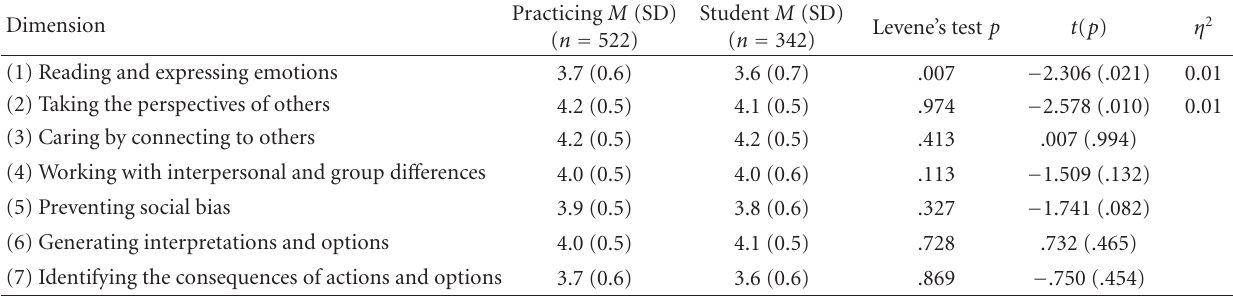
Table 3: Teaching career stage-related di ff erences in ethical sensitivity.